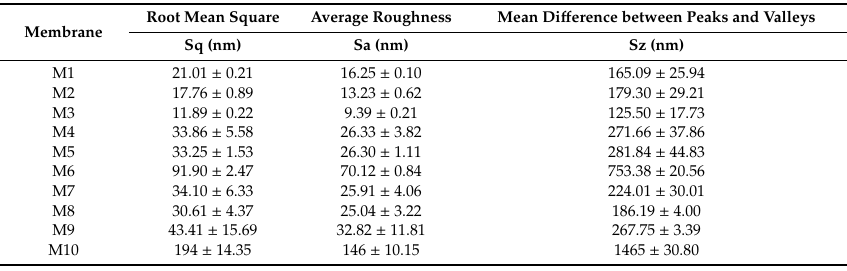
Table 3. The roughness parameters of the membranes under study.